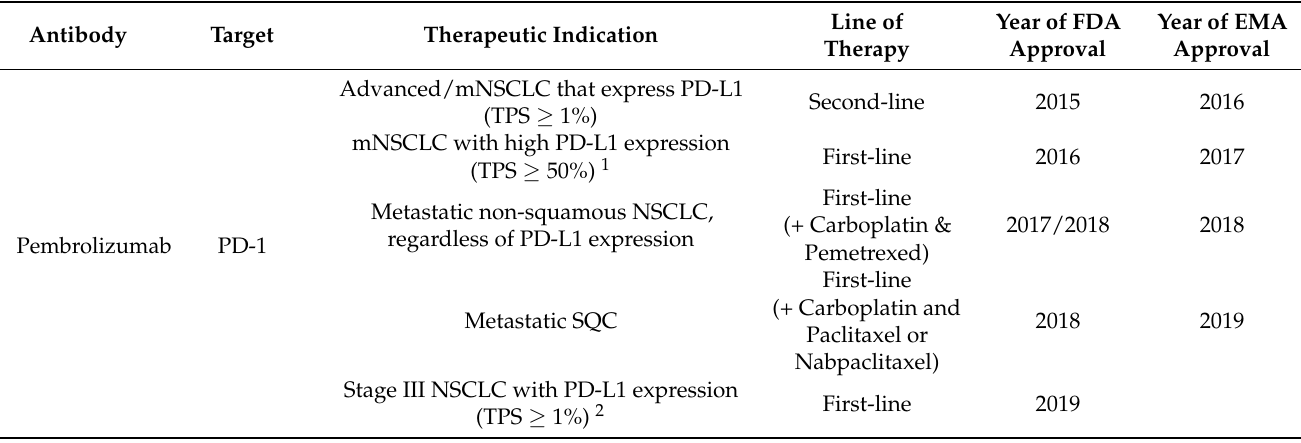
Table 2. Summary of immune checkpoint inhibitors approved for NSCLC treatment. The table was created based on the FDA and EMA database of approved anti-PD-1/PD-L1 therapeutics for the treatment of NSCLCs. FDA—The Food and Drug Administration; EMA—European Medicines Agency; mNSCLC—metastatic non-small cell lung cancer; TPS-tumor proportional